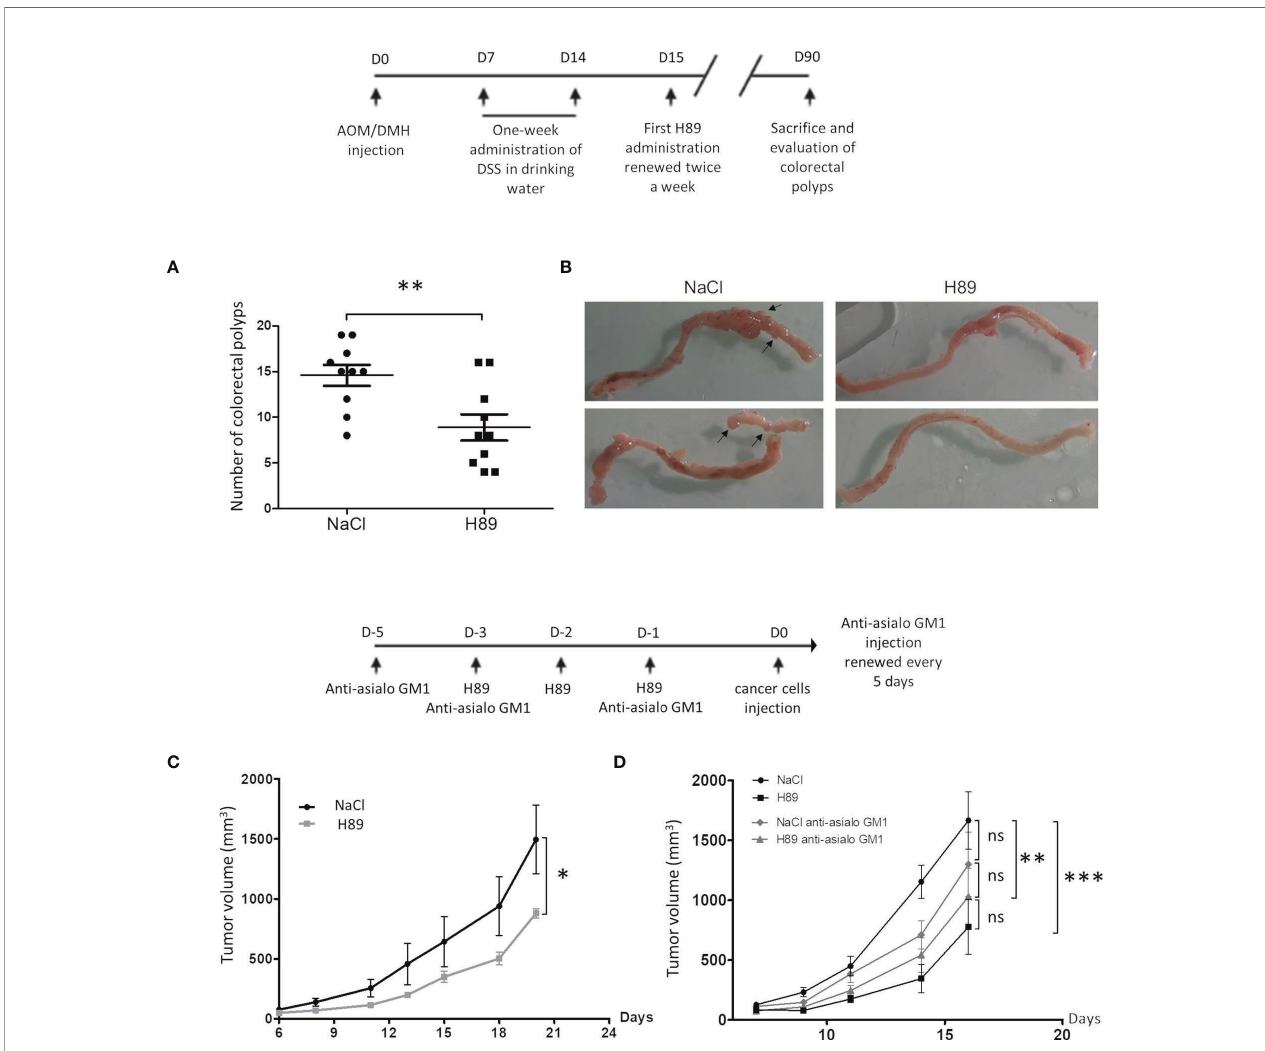
FIGURE 1 | H89 delays tumor growth and AOM/DSS-driven carcinogenesis. (A) Macroscopic evaluation of the number of colorectal polyps in BALB/c mice with AOM/DSS-induced colorectal carcinoma, treated or not with H89 (5 mg/kg, oral administration) twice a week ( n = 10 mice/group). (B) Macroscopic images of mouse colons treated or not with H89. (C) To assess the preventive effect of H89 in CT26-bearing BALB/c mice, H89 (or NaCl in the control group) was injected for 3 days in a row (10 mg/kg, i.p.). On day 4, 5 × 10 5 CT26 cells were injected in s.c., and tumor growth was monitored three times a week ( n = 5). (D) Two days before the fi rst H89 injection, mice were treated with an anti-asialoGM1 to deplete NK cells (10 µl in 100 µl of NaCl according to the supplier ’ s instructions). Anti- Asialo GM1 Injections were repeated during the fi rst and the last H89 injections, and then every 5 days ( n = 7 mice/group). Statistically signi fi cant differences were determined by using a t -test (A) or two-way ANOVA (C, D) ; * p ≤ 0.05; ** p ≤ 0.01; *** p ≤